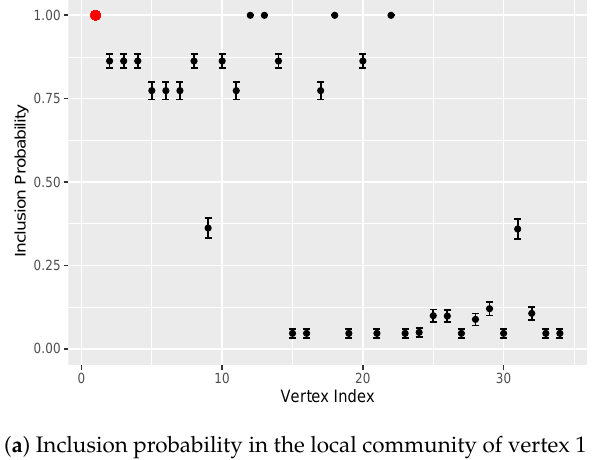
( b ) Inclusion probability in the local community of vertex 34